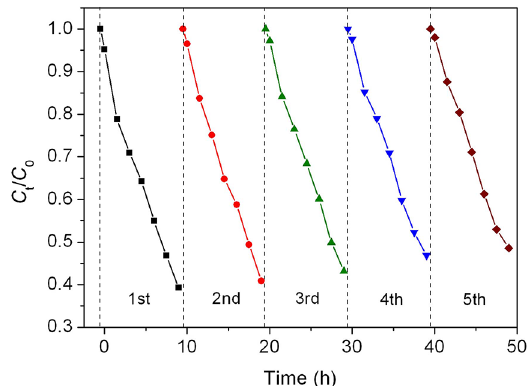
Figure 7. Photocatalytic recyclability of 16CN/BFO sample for the degradation of MB under simulated sunlight irradiation. Initial conditions: C (MB) = 5 mg/L, T = ~